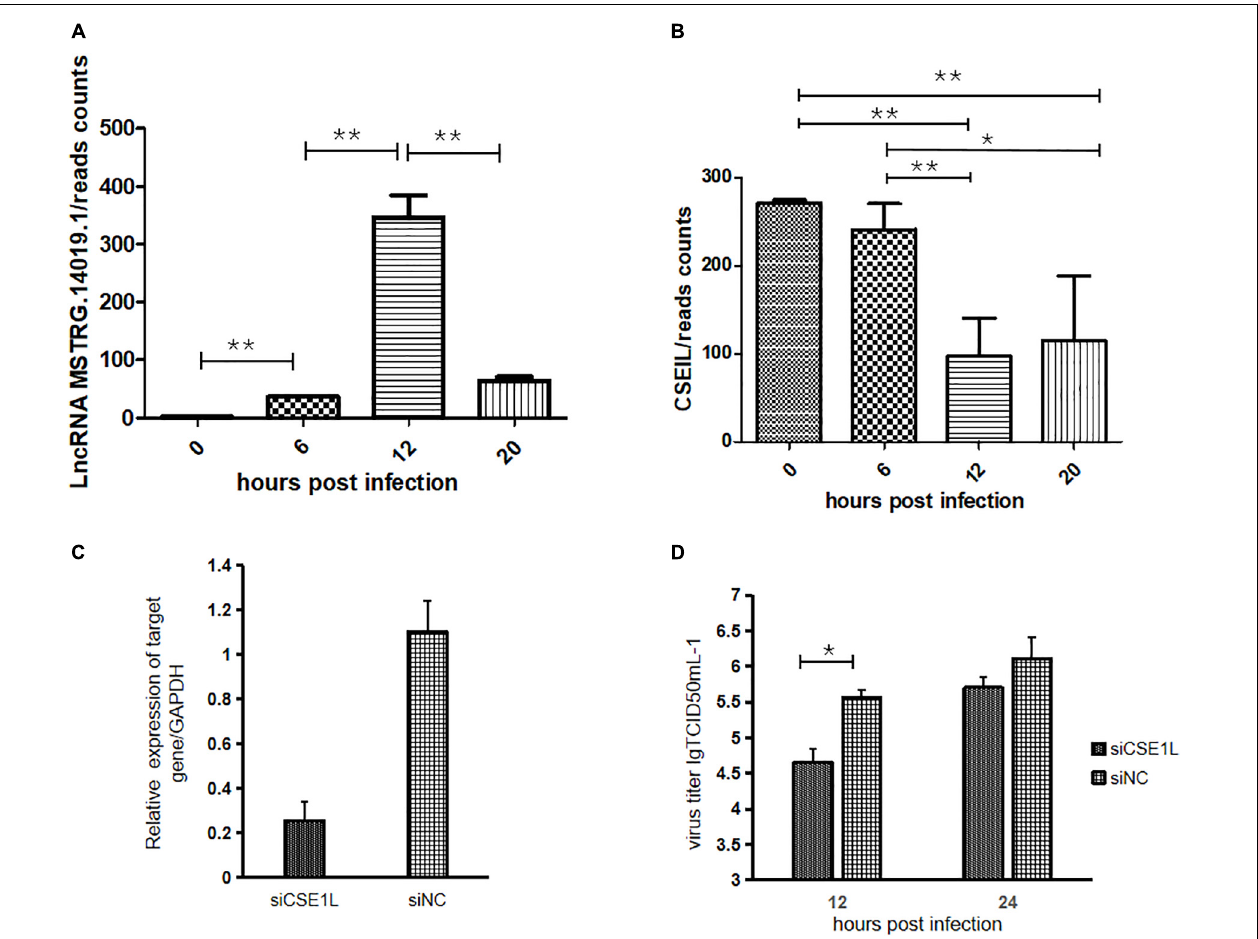
FIGURE 5 | LncRNA MSTRG.14019.1 targeting to CSE1L inhibits the replication of H5N1 AIV. (A) Expression levels of lncRNA MSTRG.14019.1 at different time points after H5N1 AIV infection. (B) Expression levels of CSE1L at different time points after H5N1 AIV infection. (C) The expression of CSE1L was dramatically reduced in specific siRNA-treated DF1 cells. (D) Progeny virus titers after transfection of DF1 cells with siCSE1L and infection with H5N1 AIV for 12 or 24 h. * p < 0.05 and ** p <